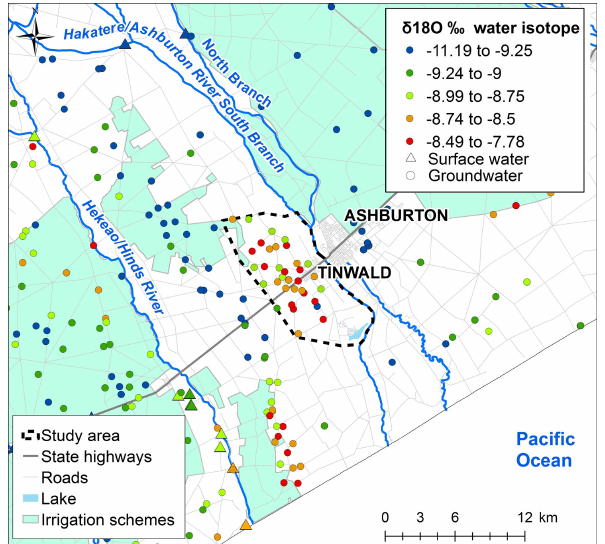
Figure 6. δ 18 O in the Ashburton area at groundwater and surface water sites. Data outside of the Tinwald study area are mean δ 18 O from all available measurements; inside the study area δ 18 O is the single result from the current sampling. Base map © LINZ (2019).